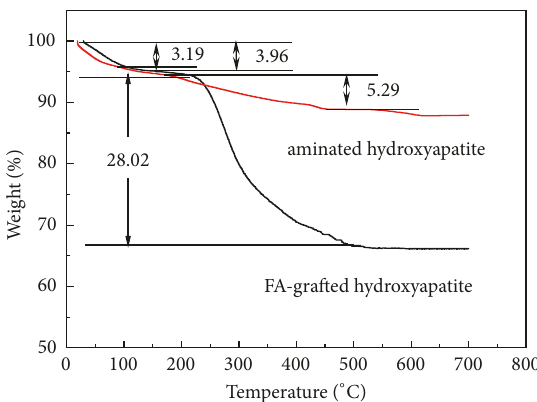
Figure 5: TGA curves of the aminated and FA-grafted hydroxyap-